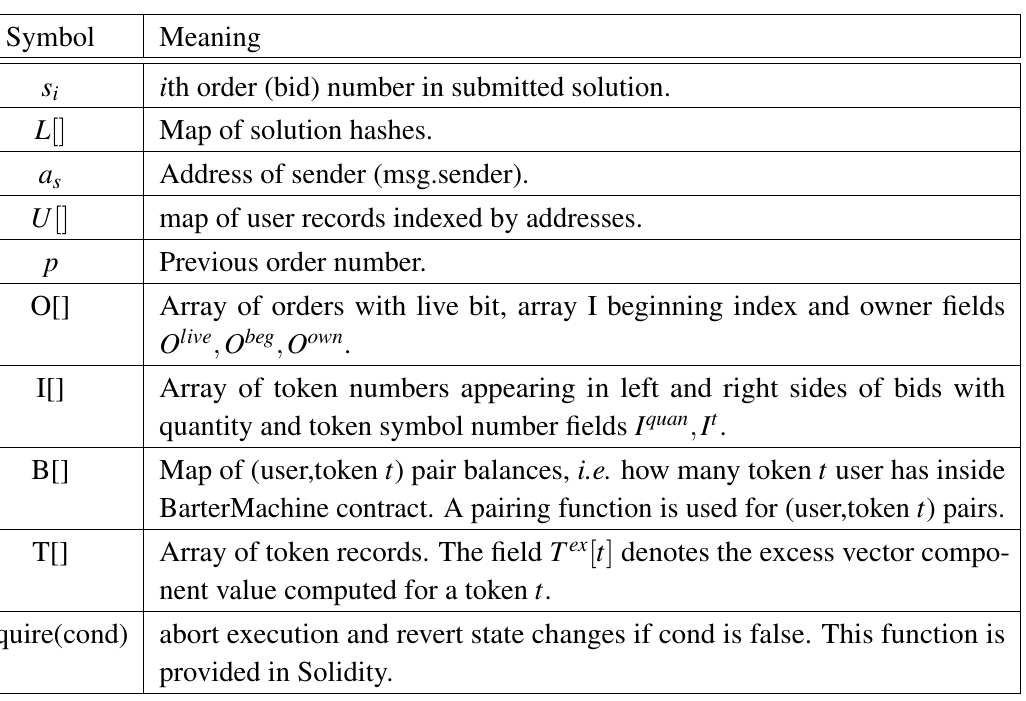
Table 2. Symbols used in SubmitSoln